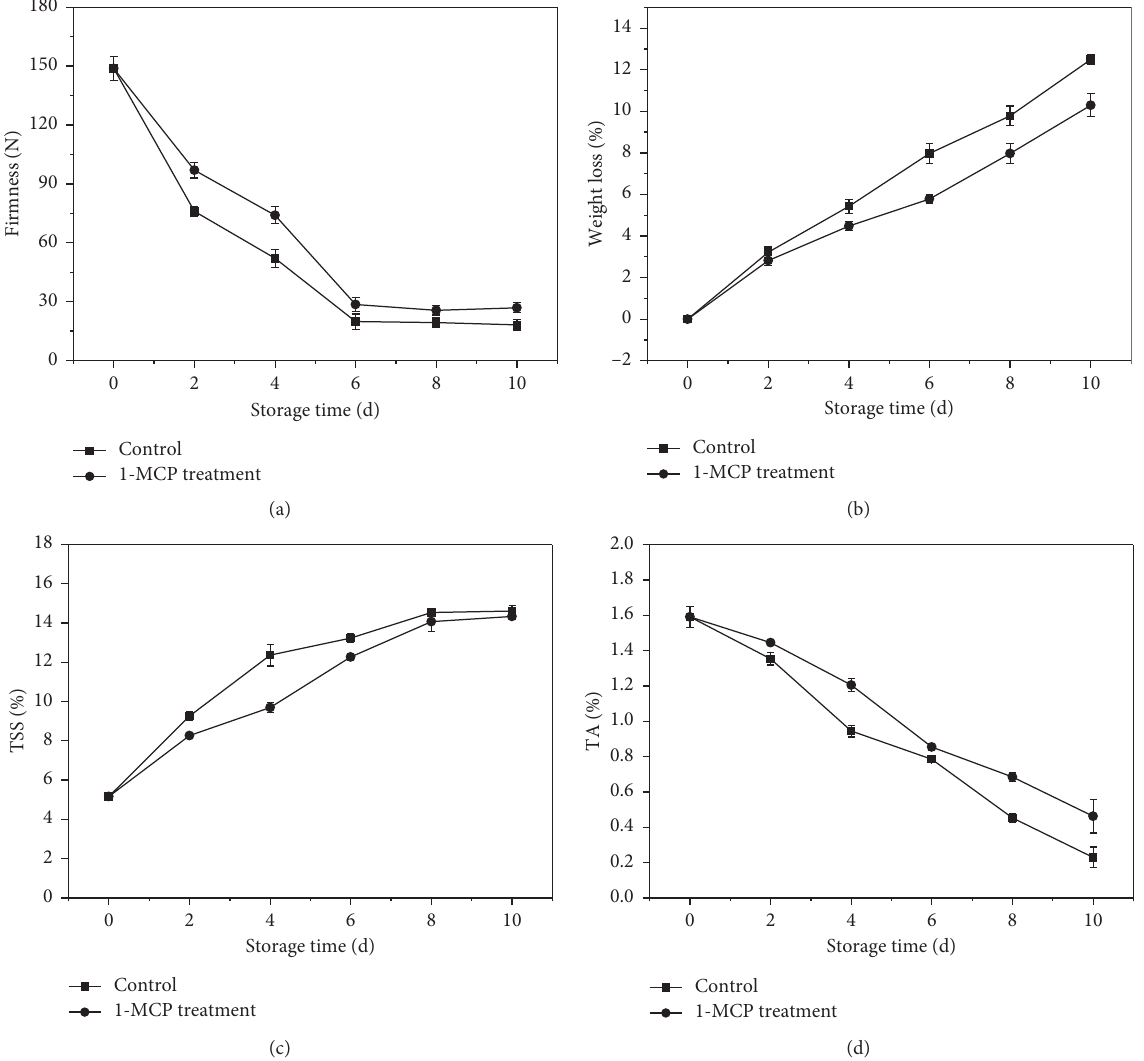
Figure 1: Effects of 1-MCP treatment on firmness (a), weight loss (b), TSS (c), and TA (d) of mango fruit during storage at 25 ° C. The data are the means of triplicates ± standard